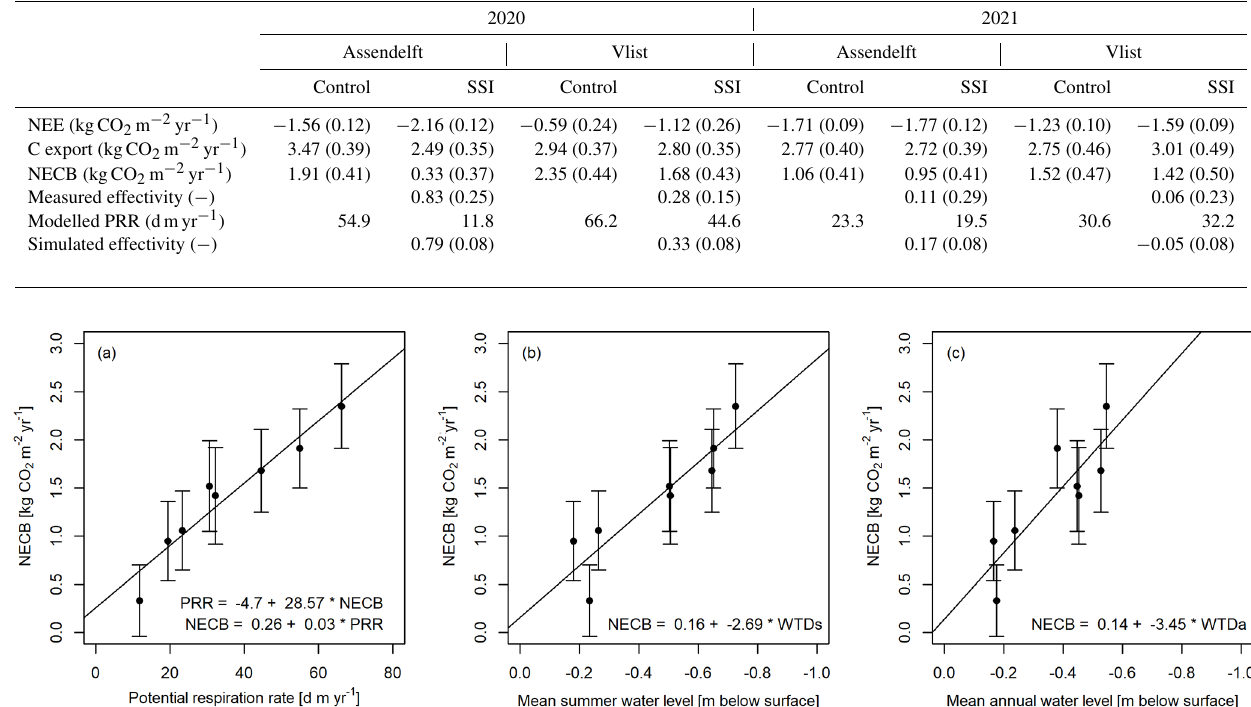
Figure 7. The relations between measured NECB (kgCO 2 m − 2 yr − 1 ) and (a) potential microbial respiration rate (PRR, dmyr − 1 ), (b) mean summer water level (WTD s , metres below surface) and (c) mean annual water level (WTD a , metres below